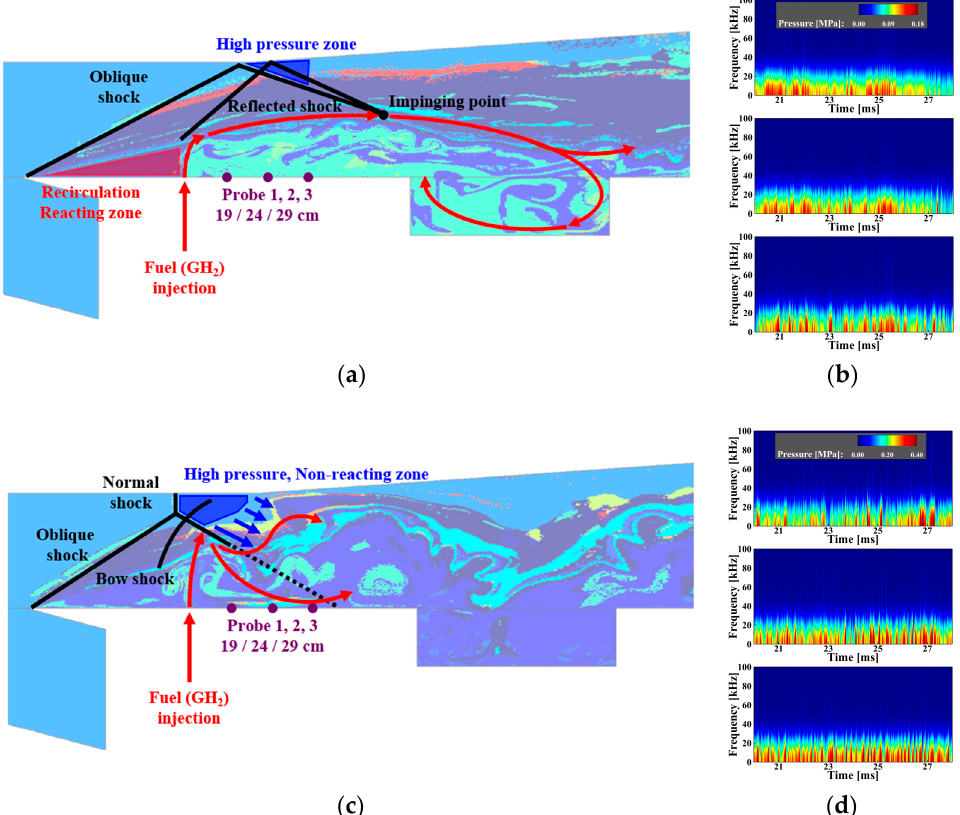
Figure 11. Schematic diagram of the reacting flow field and the STFT results for pressure at probe points 1, 2, and 3: ( a ), ( b ) 0.75 MPa; ( c ), ( d ) 1.0 MPa injection pressure condition.